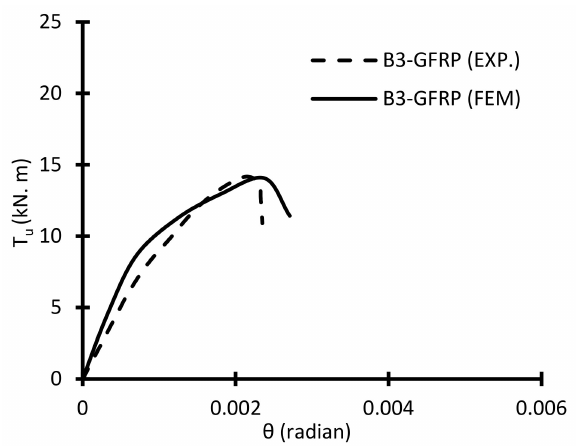
Figure 37. Torque-twist curves of the beam B2-SS (FEM and EXP.).